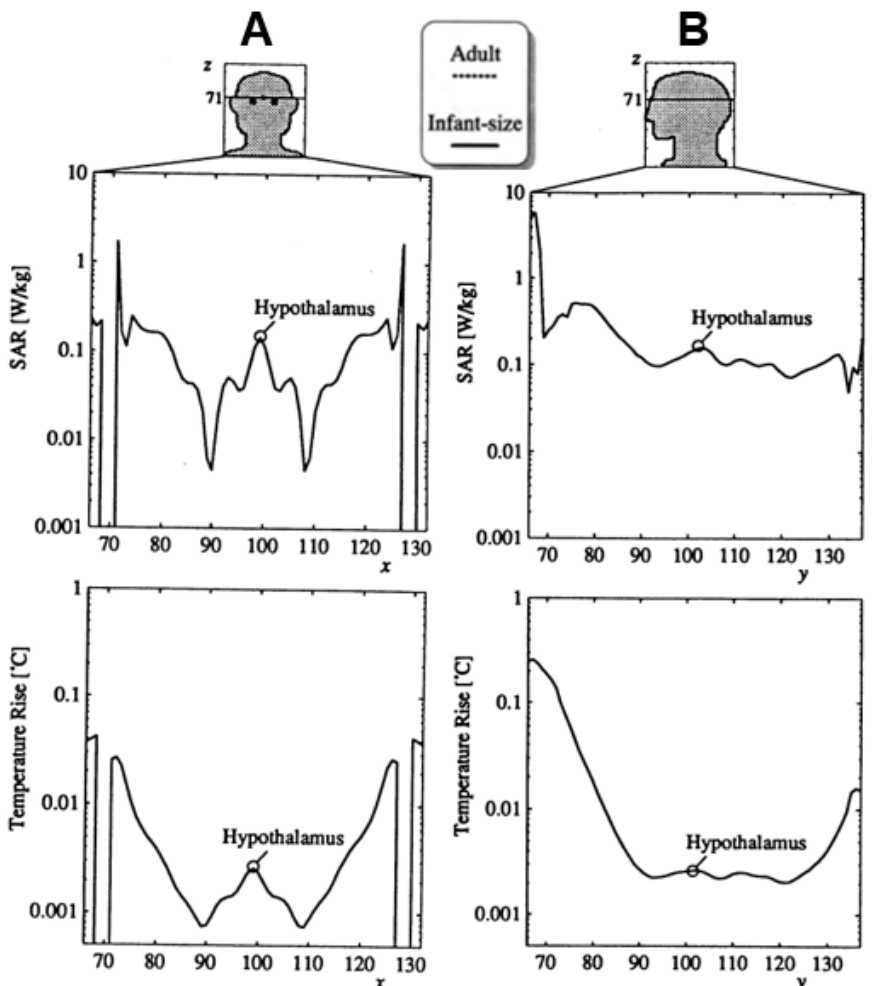
Figure 6. Partial distribution of (A) SAR and (B) temperature rise in the line passing through the centre of realistic head models, both from front to the back side and from the right to the left side